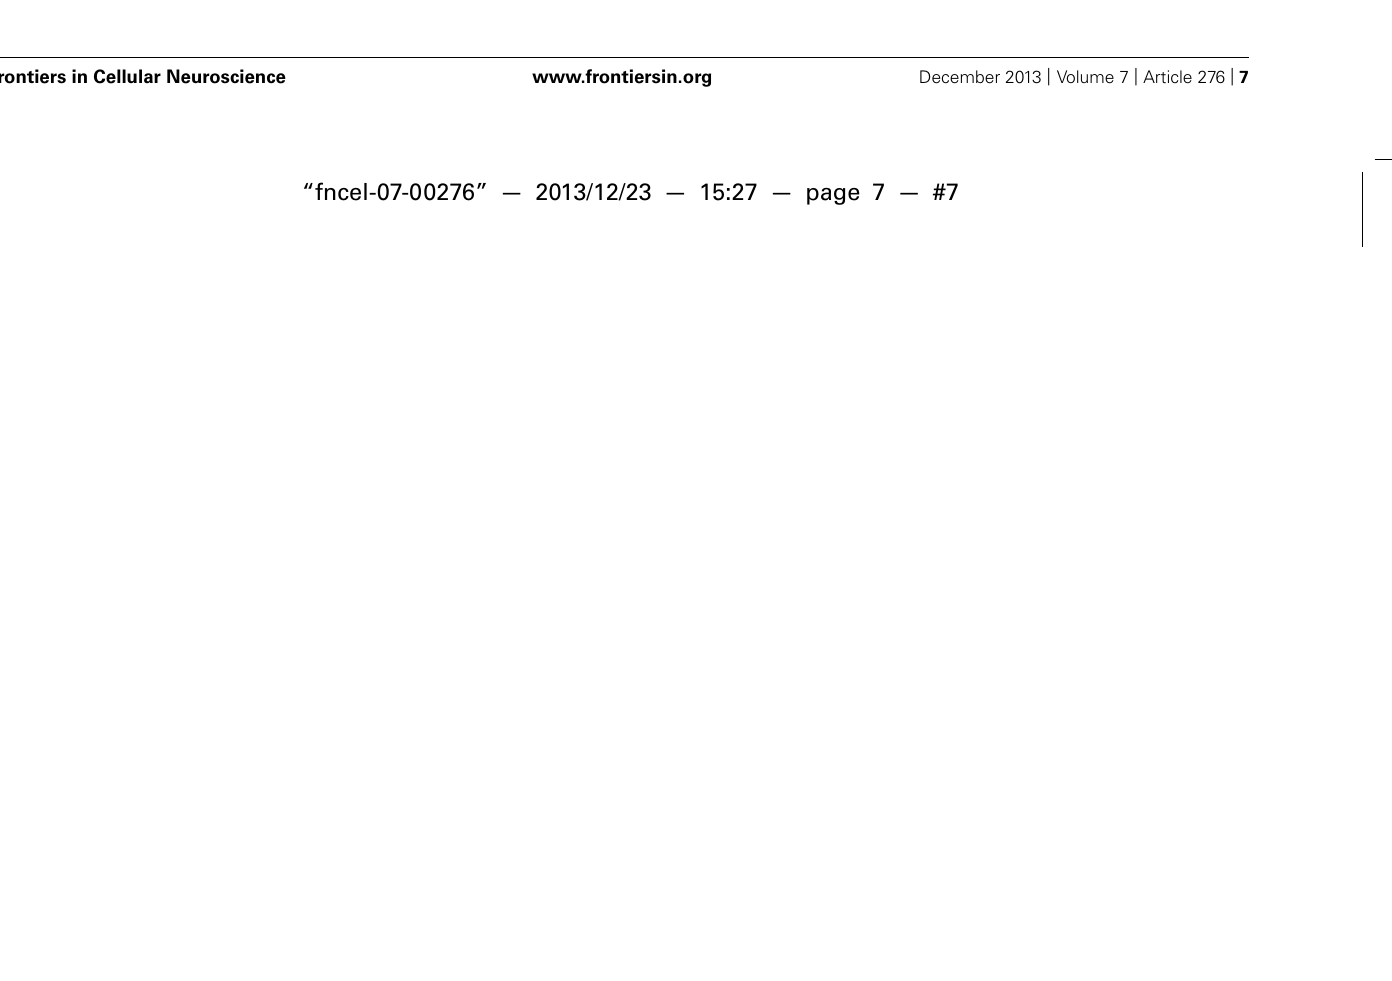
FIGURE 5 | Plateau potentials in DHN shape naturally evoked sensory inputs. (A) Incrementing firing frequency due to activation of a plateau potential. The stimulus was followed by an after-discharge terminated by a hyperpolarizing current pulse. (B) Response to brush on a spot of the receptive field (inset) at different membrane potentials. (C) A sinusoidal (60 Hz, lower inset) mechanical stimulation with a fine probe on a spot